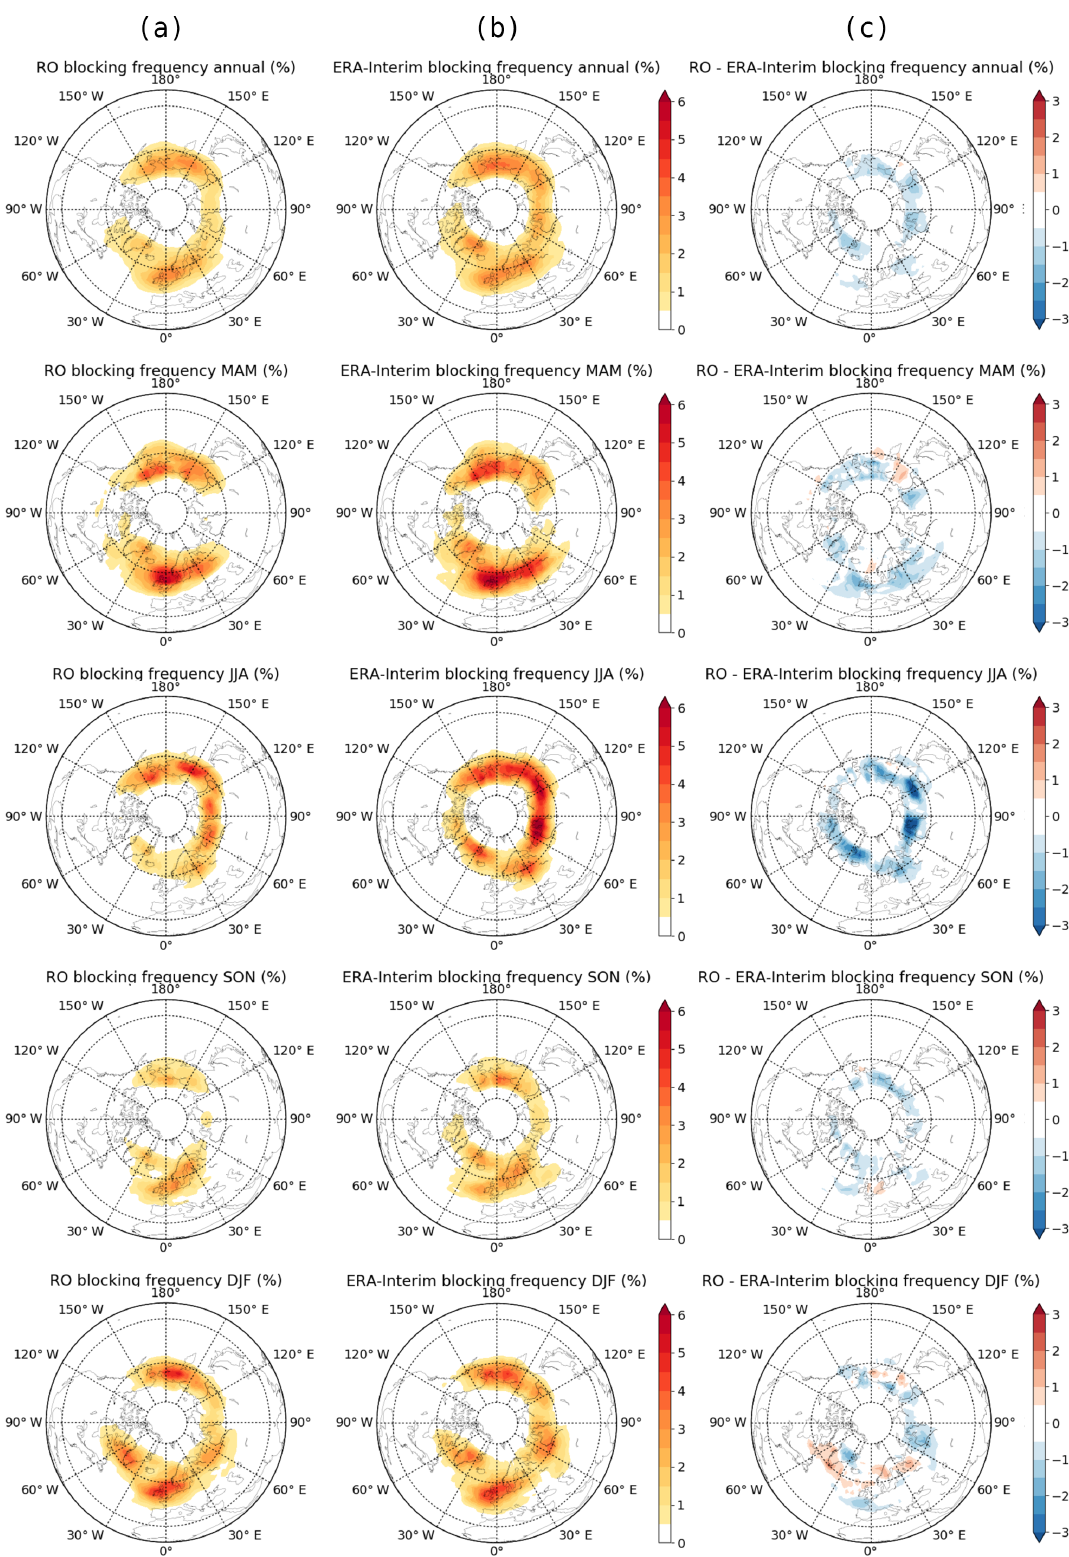
Figure 3. Blocking frequencies for the Northern Hemisphere in the period September 2006 to August 2016. Frequencies are shown for (a) RO, (b) ERA-Interim, and (c) RO minus ERA-Interim for (from top to bottom) the annual mean and seasonal means, spring, summer, fall, and